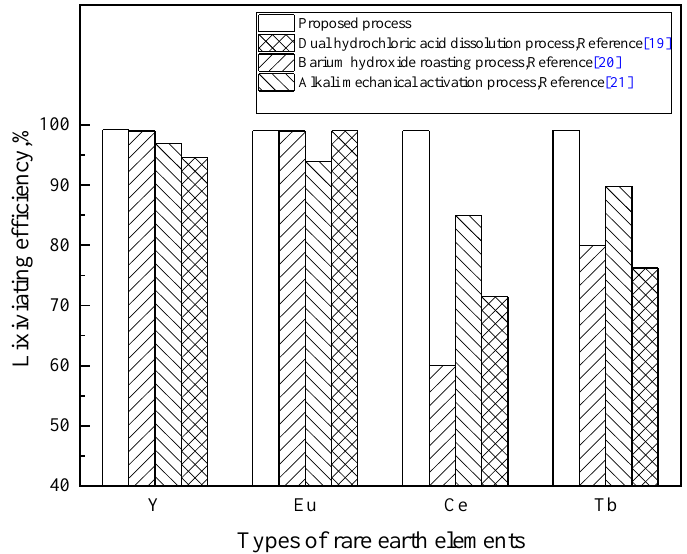
Figure 14. Leaching efficiency of rare earth elements by different methods [19–21].